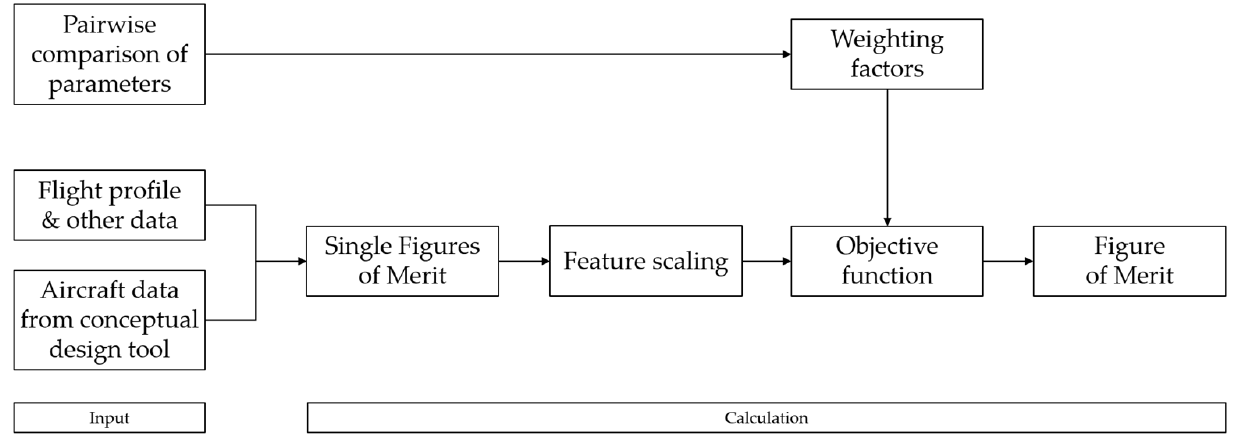
Figure 13. Calculation method for the figure of merit.